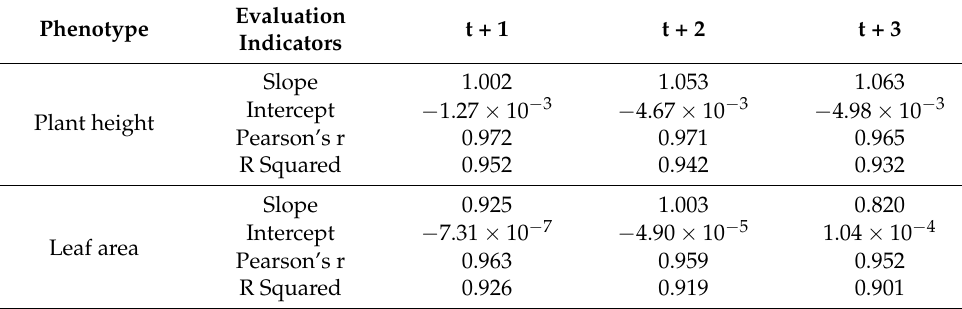
Table 5. Evaluation indicators of LSTM time series